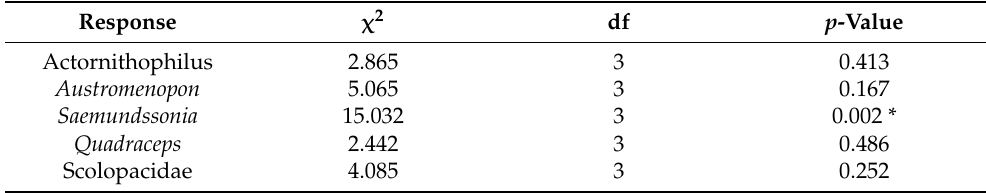
Table 11. Likelihood ratio test results for fitted model with migration length and host weight compared to null model (containing only the random effect). An asterisk (*) designates the only statistically significant